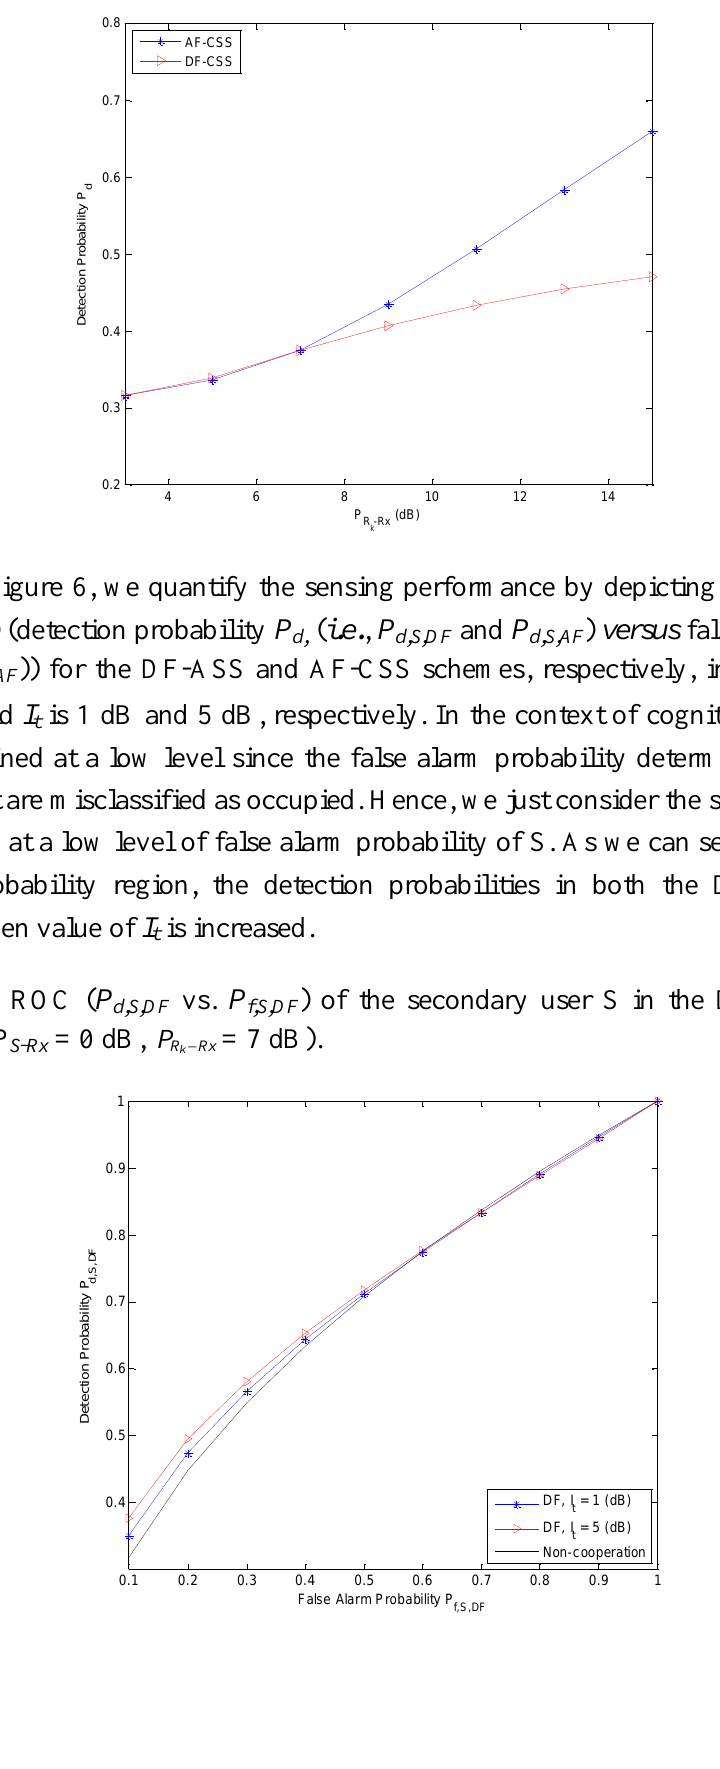
Figure 4. Detection probability P between the DF-CSS and AF-CSS schemes as a d function of the received power from the primary user P at the secondary user P  k R Rx R (P = 3 dB, P = 0 dB, I = 5 dB). k D-Rx S-Rx t